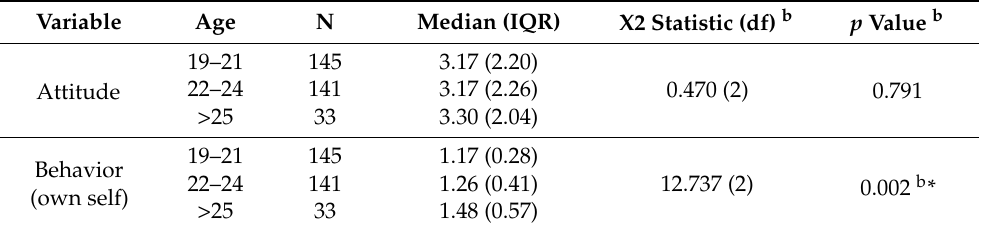
Table 3. Association between age and students’ attitudes and behavior towards academic dishonesty during online learning.